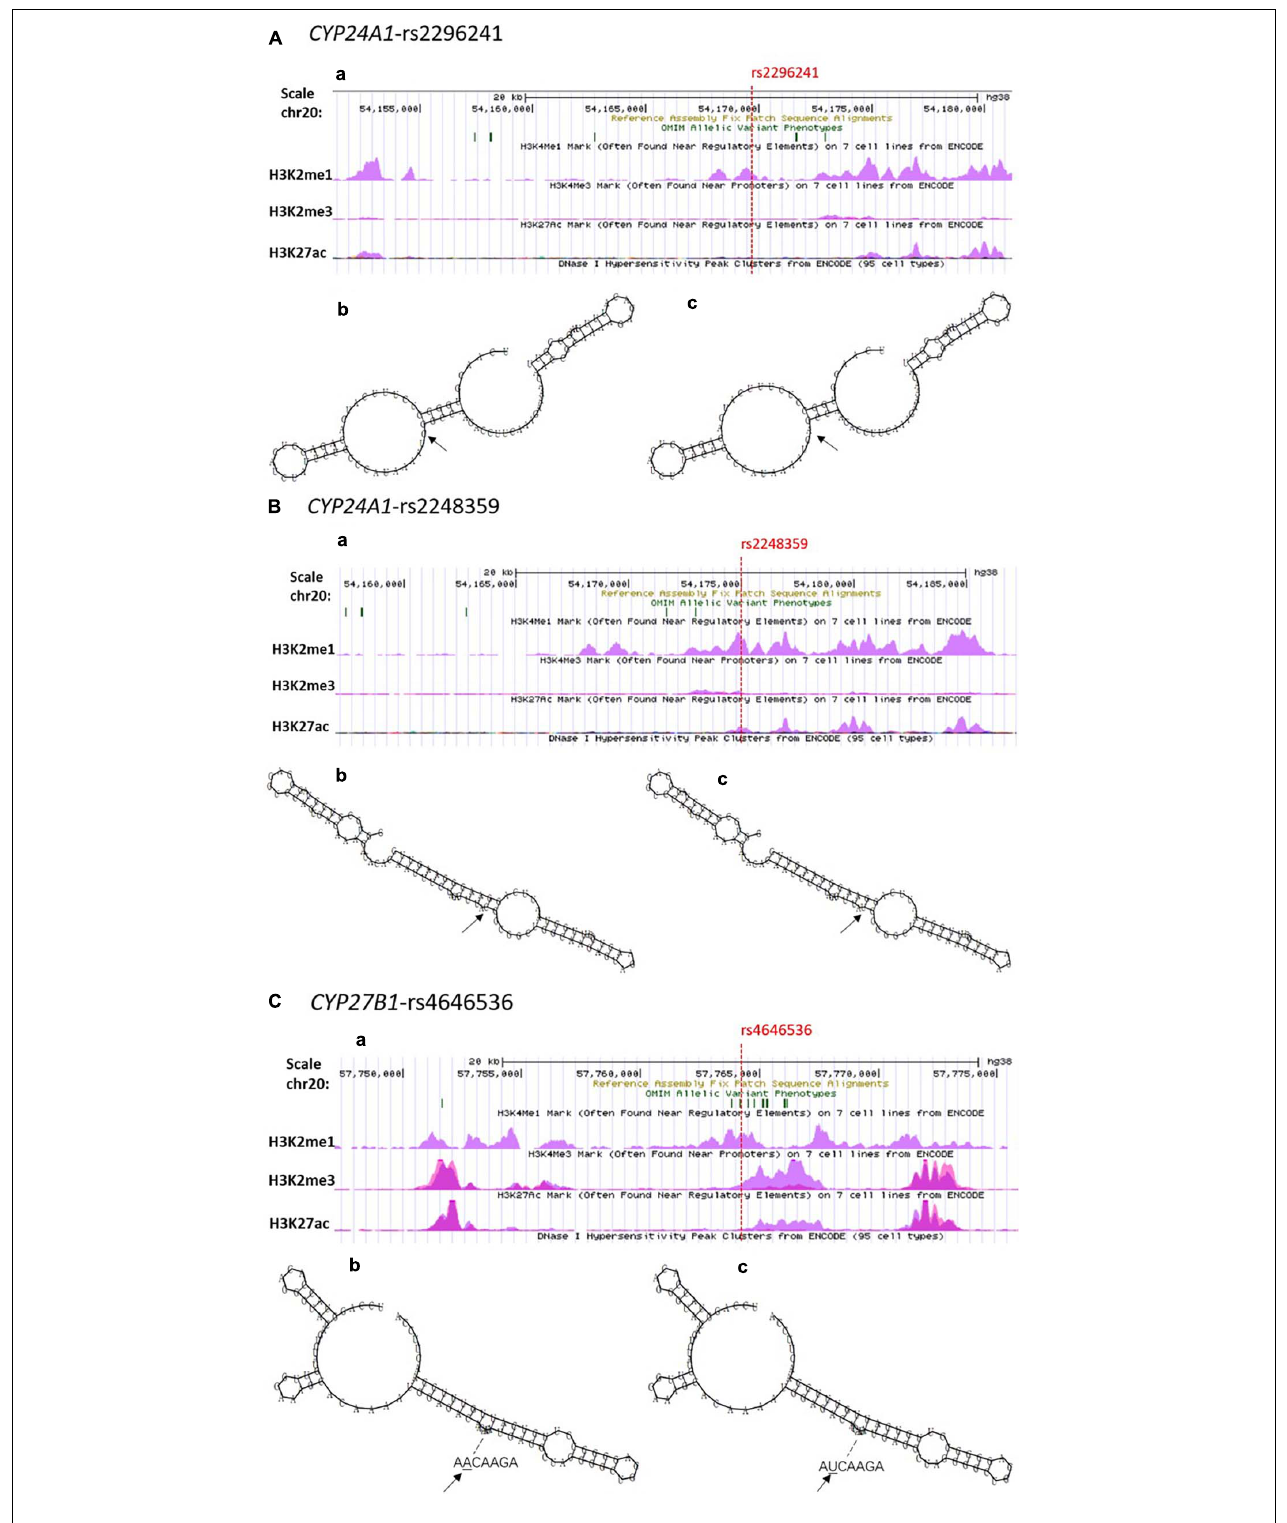
FIGURE 2 | Functional prediction of positive SNPs in CYP24A1 and CYP27B1 . Notes. (A) CYP24A1 -rs2296241; (B) CYP24A1 -rs2248359; (C) CYP27B1 -rs4646536. (a) USCS functional annotations of SNPs, respectively. The red dotted line indicated the position of target SNPs (available at http://genome.ucsc.edu/). (b , c) Influence of SNPs on the mRNA secondary structures. (b) Wild-type sequence; (c) mutant-type sequence. The arrows indicate the